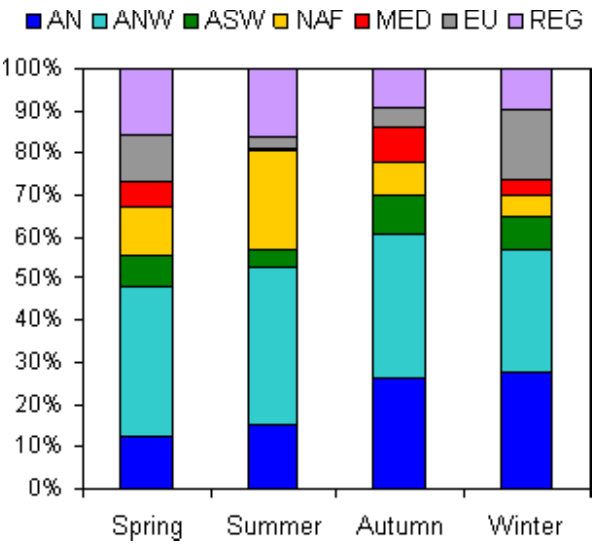
Fig. 2. Frequency of air mass origin as a function of season at Montsec.